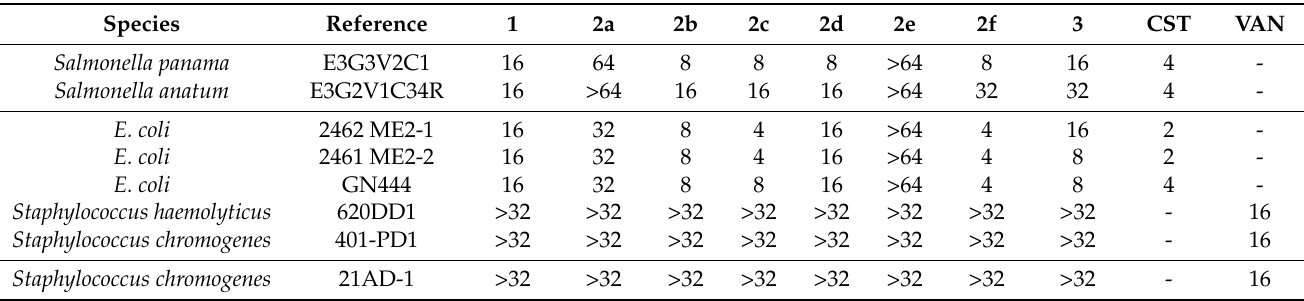
Table 3. Summary of the MBIC values (mg/L) of the (CˆS)-cyclometallated Au(III) complexes and standard antibiotics under